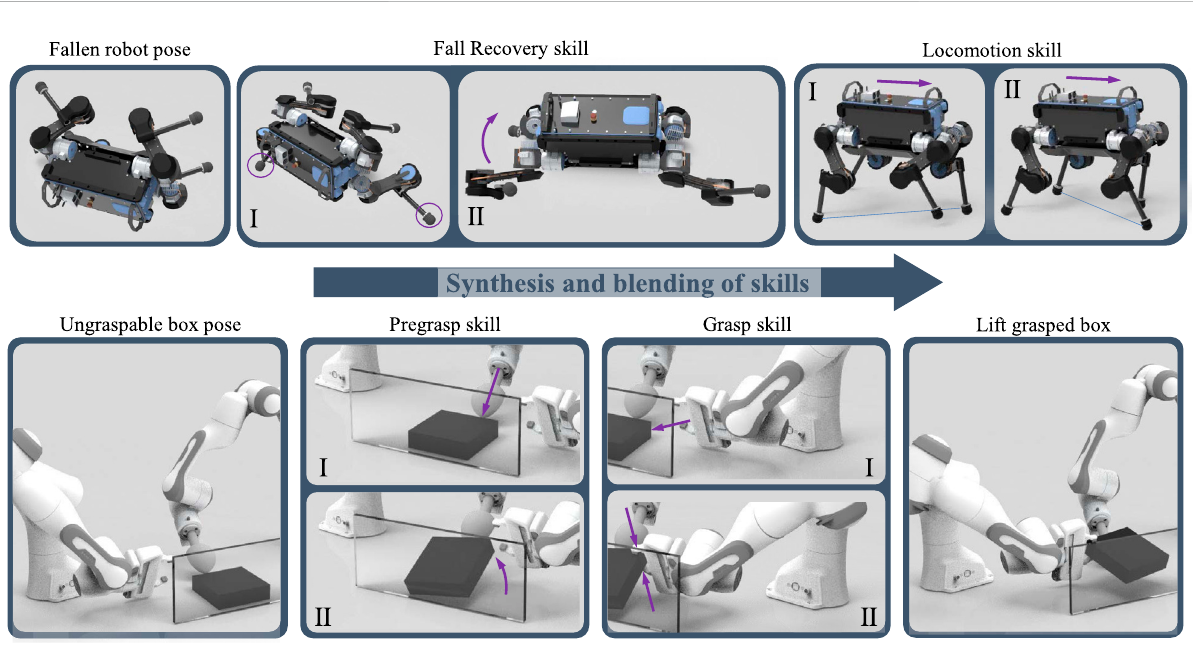
FIGURE 1 SynthesisofexpertskillsusingMulti-ExpertSynthesis.Top:Versatilelocomotionbyrecoveringfromaproneposition fi rstandthentransitioning into trotting. Bottom: Dual-arm cooperative manipulation, where the object is fi rst recon fi gured by the left hand into a graspable pose and then grasped by the right